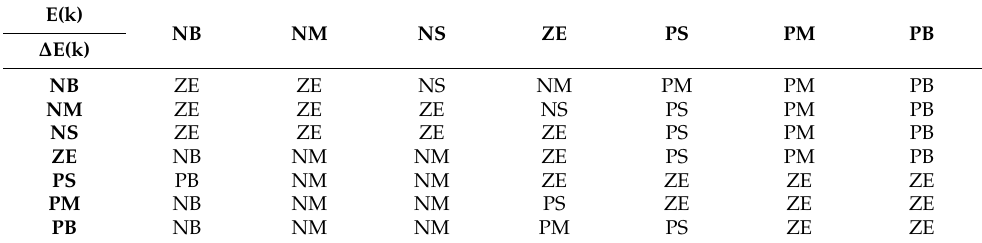
Table 2. Rules of the